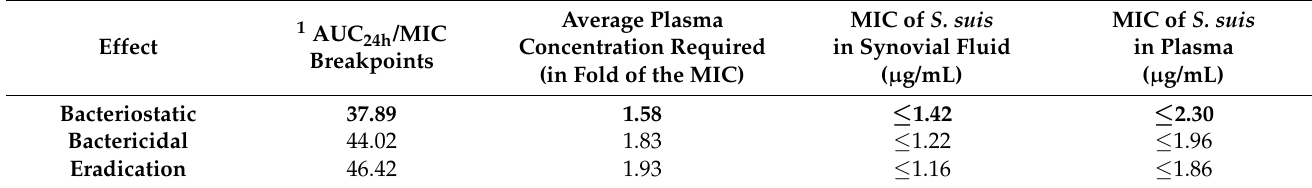
Table 3. Mean indicative MIC breakpoints of florfenicol against S. suis for bacteriostatic, bactericidal and eradication effects. The required average plasma concentration should be a multiple of the flor- fenicol MIC against S. suis . Critical MICs of S. suis in synovial fluid and plasma were calculated based on the breakpoints of Lei et al. [3]. Our AUC 0- ∞ in plasma and synovial fluid (87.14 ± 31.50 µ